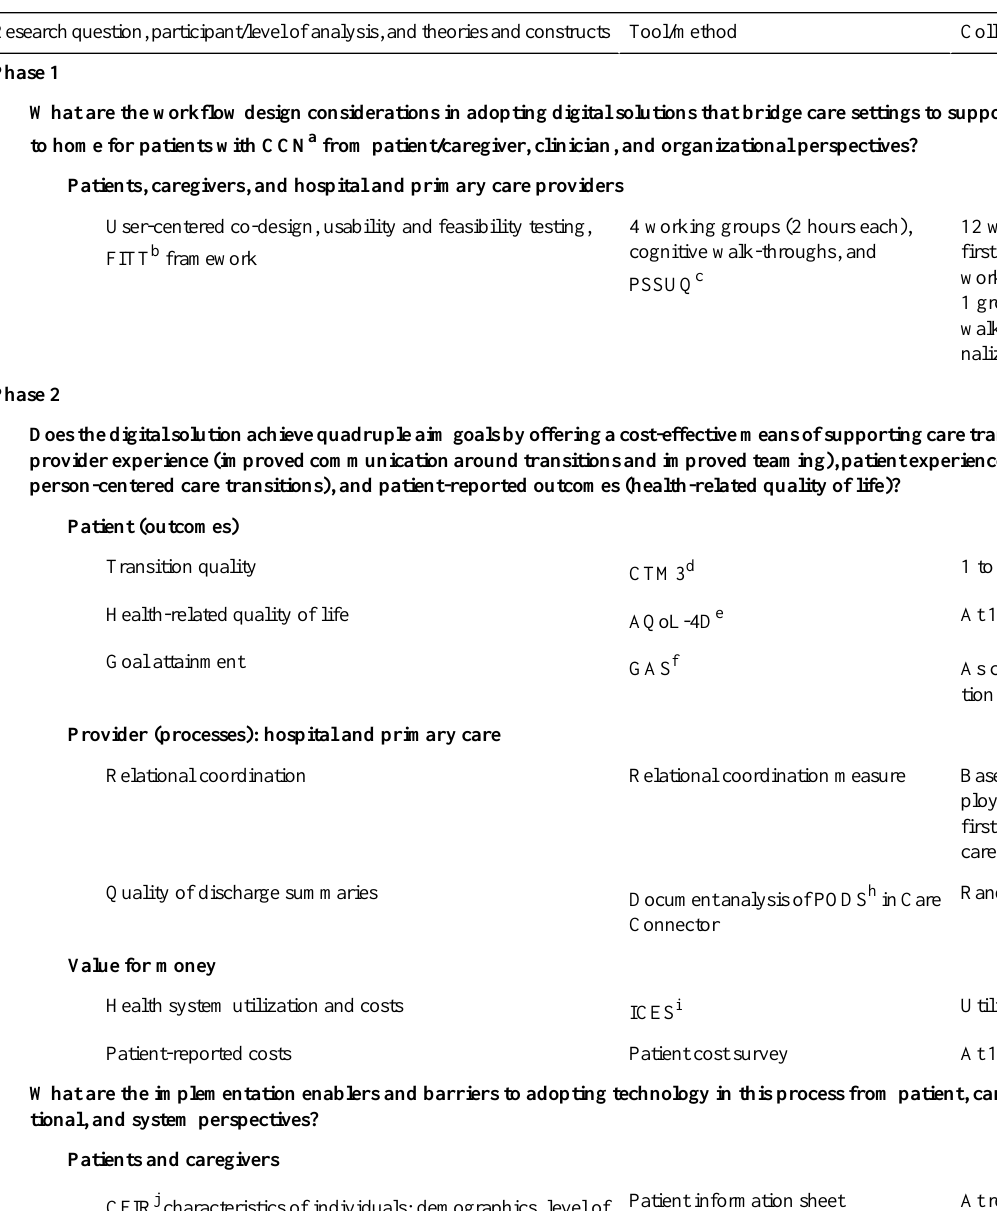
Table 1. Data collection tools and